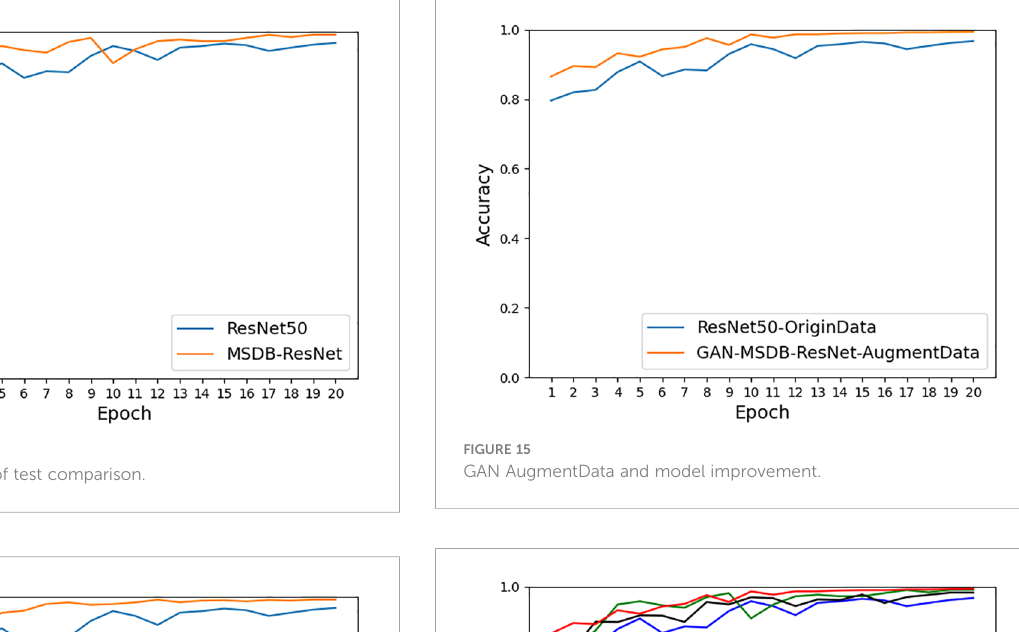
FIGURE 12 Model improvement of test comparison.